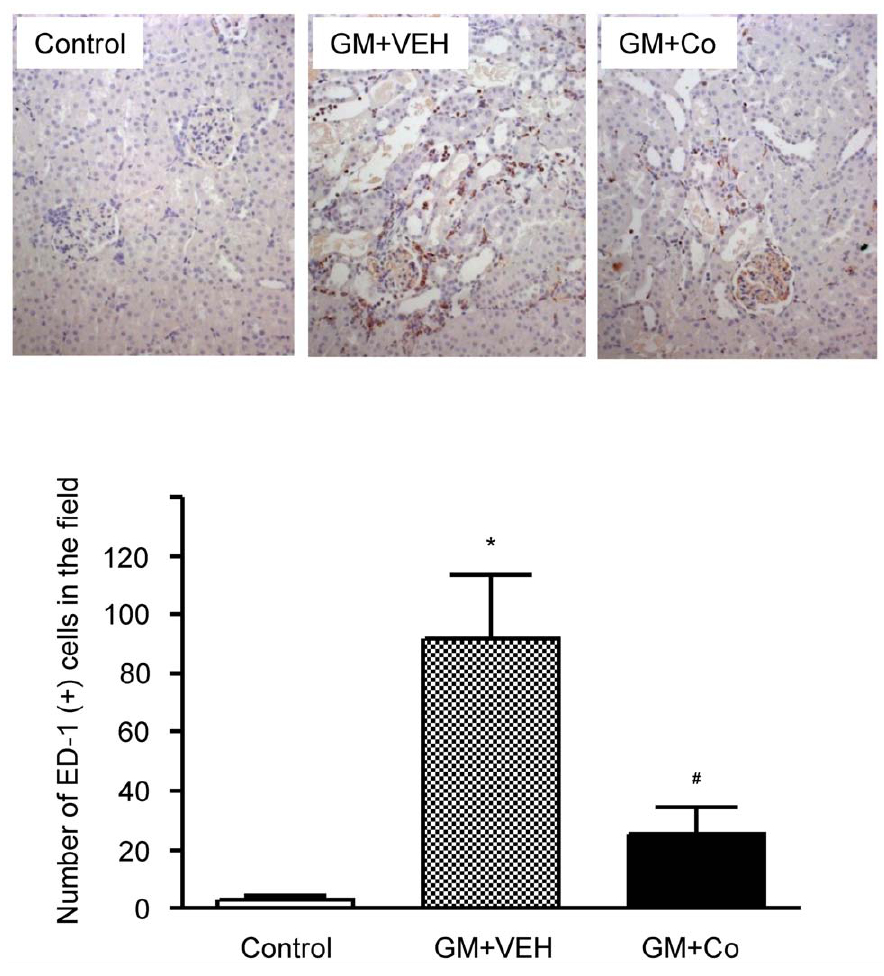
Figure 7. Effects of gentamicin and cobalt on the infiltration of macrophages in rat kidneys. Immunohistochemical stains for ED-1 in representative renal cortices of experimental animals. The number of ED-1-positive cells per field was counted in each group. The results are expressed as the mean 6 s.d. *Significantly different with respect to control rats. # Significantly different with respect to the rats treated with gentamicin and vehicle. * # P , 0.05. GM + VEH, gentamicin and vehicle treatment; GM + Co, gentamicin and cobalt treatment. Magnification 6